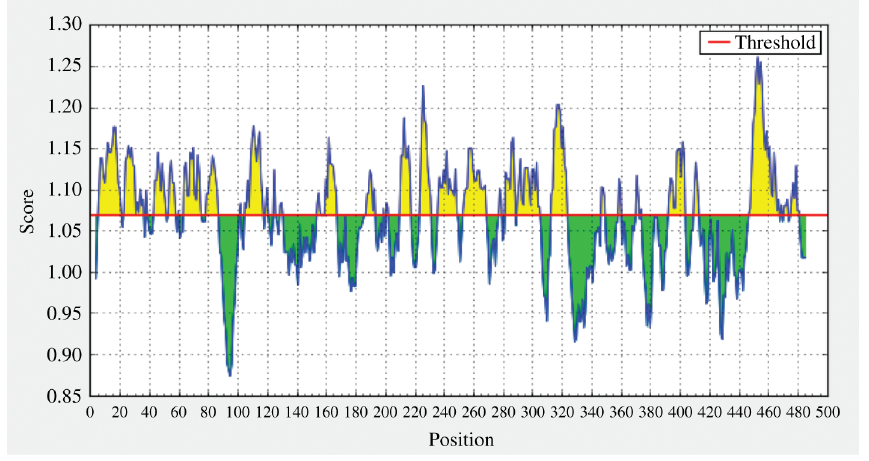
Figure 6: Predicting linear B-cell epitope by using Kolaskar and Tongaonkar prediction tool. Here, the picks rise above the threshold sequence can act as B-cell epitope to induce humoral immune response. The aver- age score of the antigen gp62 of HTLV-1 is found to be 1.069. Nineteen peptides (Table 5) are found to be a potential antigen that satisfies the set threshold value. The peptide “ ITLVALLLLVILAGPCILRQL ” ranging from 447 to 467 amino acid residue is predicted to have the highest antigenic propensity score. Table 5: Predicted Linear B cell peptides in the envelope glycoprotein gp62 of HTLV-1.